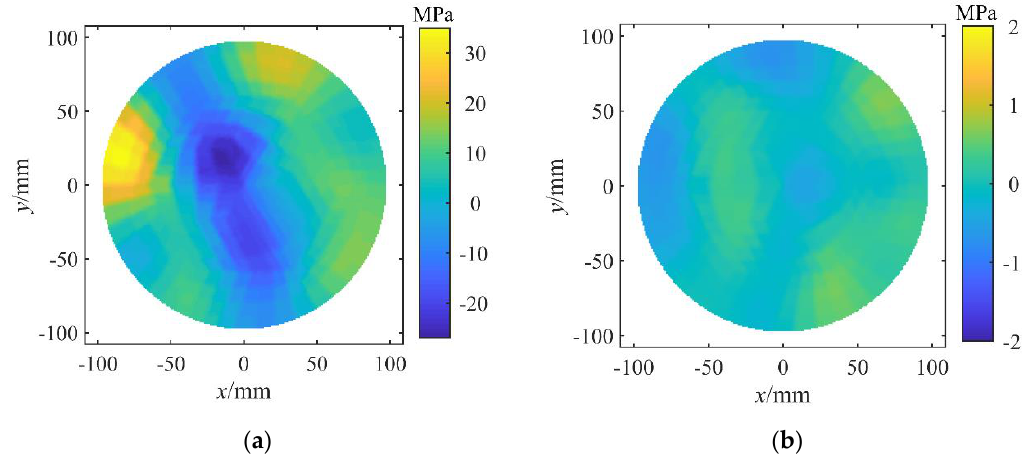
Figure 16. Calculated residual stress distribution from wafer deformation with added random errors using regularization method ( a ), and the difference from that without random errors Figure 15 ( b ). The calculated residual stress using the regularization method turned to be more robust to measurement errors.